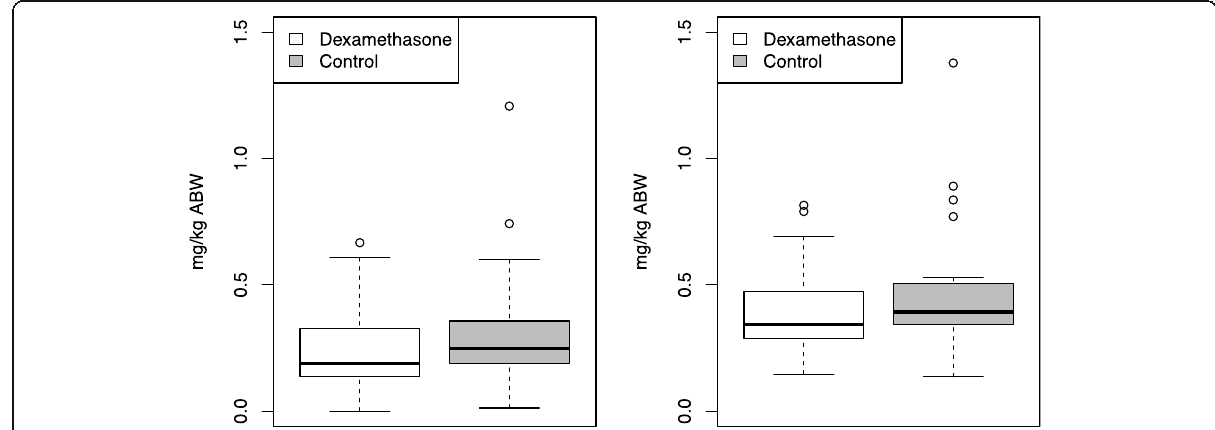
Fig. 1 Morphine consumption at 24 h in the dexamethasone and the control group. The first plot shows postoperative morphine consumption. The second plot shows the sum of intraoperative and postoperative morphine